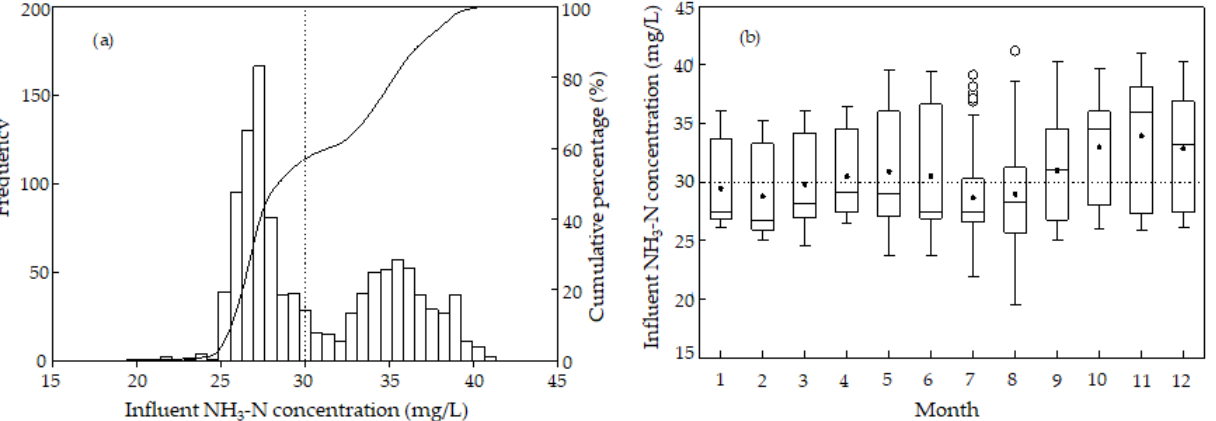
Figure 4. ( a ) Probability distribution and ( b ) monthly distribution of influent NH 3 ‐ N concentra ‐ tion. The solid circle (•) represents the average. Outliers are marked by a hollow point (°). The solid circle ( • ) represents the average. Outliers are marked by a hollow point ( ◦